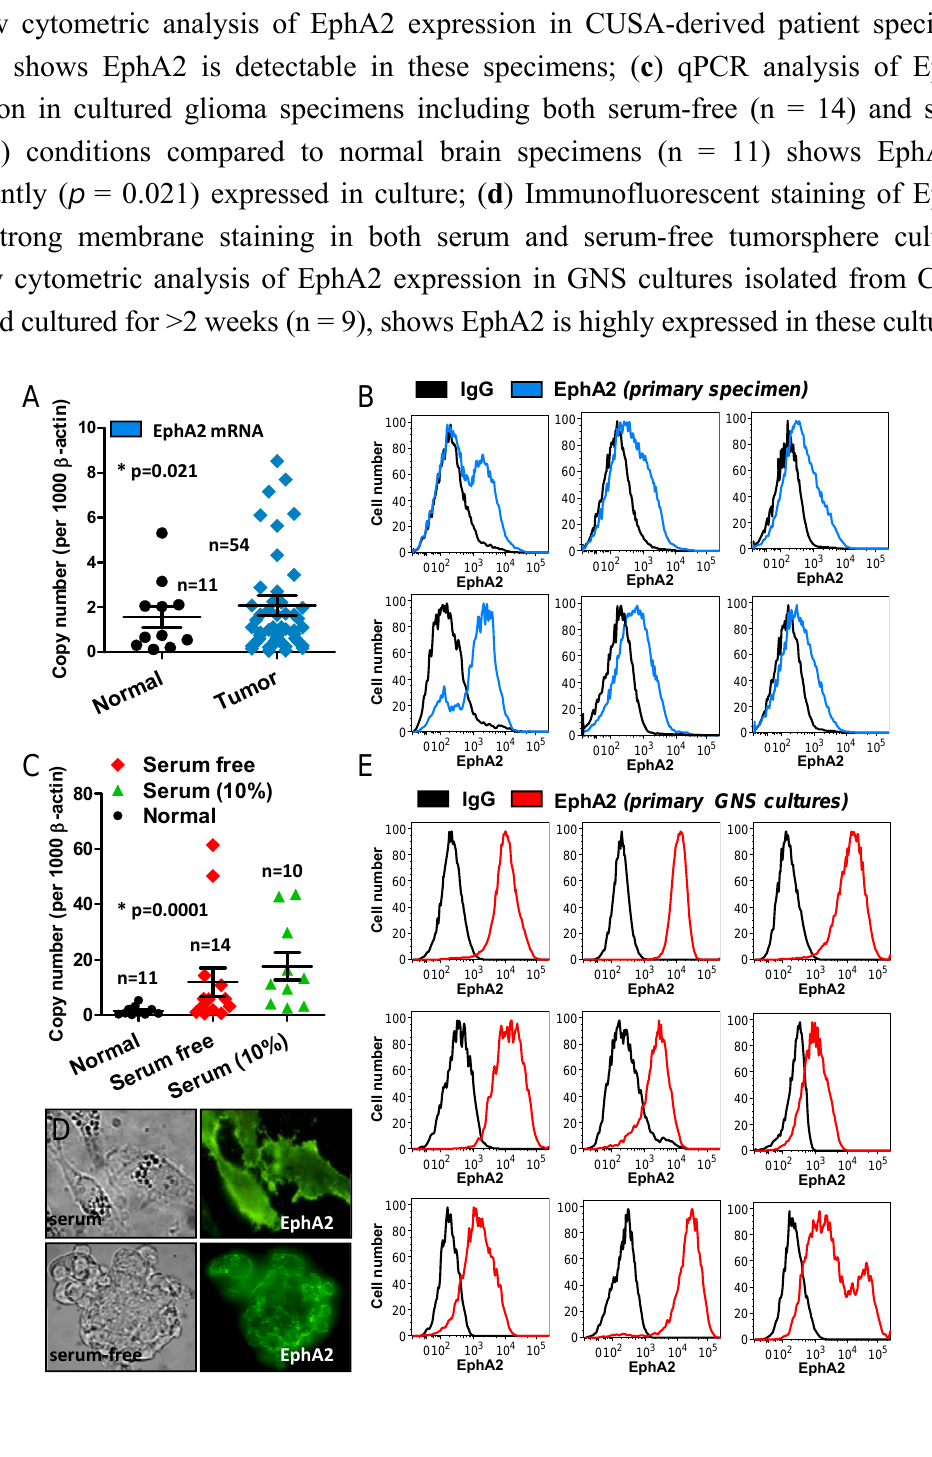
Figure 4. CUSA surgical aspirate can be used to perform tumor expression